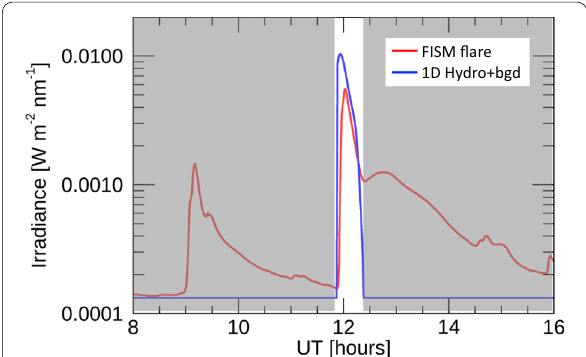
Fig. 1 Light curve of soft X-ray (1–10 Å ) emission. “FISM flare” (red line) is proportional to the light curve of GOES soft X-ray (1–8 Å ). “bgd” is the daily component of FISM which is a constant value. “1D Hydro flare” reproduces only the light curve of the X9.3 flare during 11:53–12:24 UT. “1D Hydro bgd” (blue line) is the sum of the light + curves of “bgd” and “1D Hydro flare”. Gray regions have no 1D